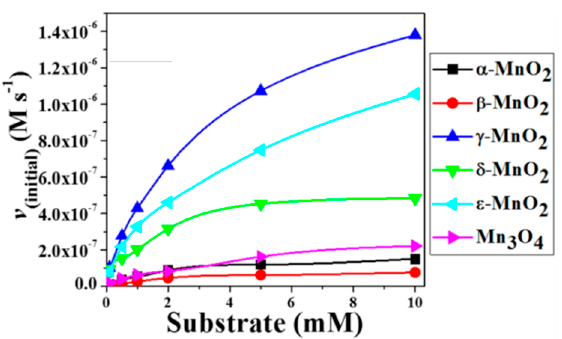
Figure 20. Degradation of ABTS with different manganese oxide materials. (Reprinted with permis-